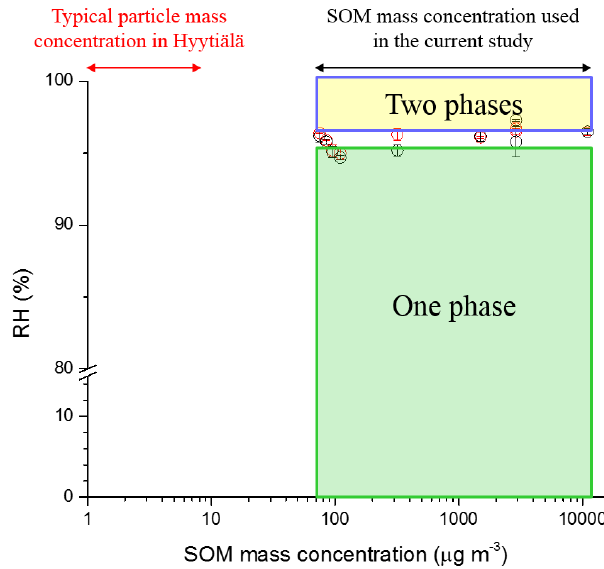
Figure 3. Relative humidity (RH) at which phase transition be- tween one phase and two liquid phases were observed for α -pinene- derived SOM as a function of the mass concentration of SOM produced. Red circles: onset of phase separation upon moistening. Black circles: merging of the two liquid phases upon drying. The y error bars represent the standard deviation in RH determination at the phase transition. Green shaded region: one phase prevalent in α -pinene-derived SOM. Yellow shaded region: two phases present. Also shown is the mass concentration observed over a representa- tive boreal forest in Hyytiälä (Raatikainen et al., 2010).